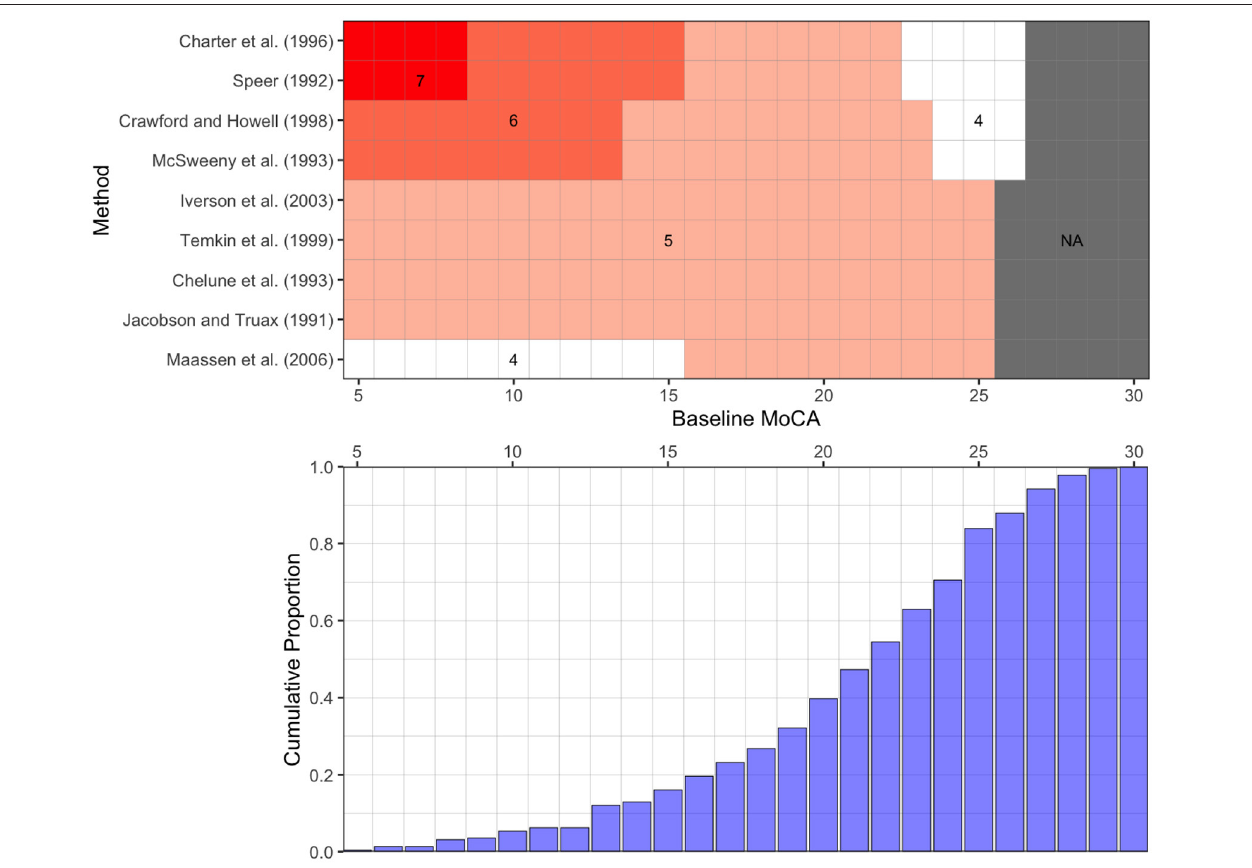
FIGURE 2 | Thresholds for Reliable Increases for the Montreal Cognitive Assessment among Patients with Suspected Normal Pressure Hydrocephalus using nine Methods. Top Panel: Given an initial MoCA score, the minimum reliable increase for a change in MoCA for nine methods. Reliable increases were generated using the 95th percentile of the prediction distribution (z = 1.64). Across all methods considered, a minimum increase of 5 points could be deemed reliable for a patient who initially presented with a score of 20. No reliable change could be determined for patients presenting with a score above 25, as the maximum possible MoCA score is 30. Bottom Panel: The proportion of patients presenting at or below a given MoCA score at baseline. For example, 20% of patients had a score of 16 or less at